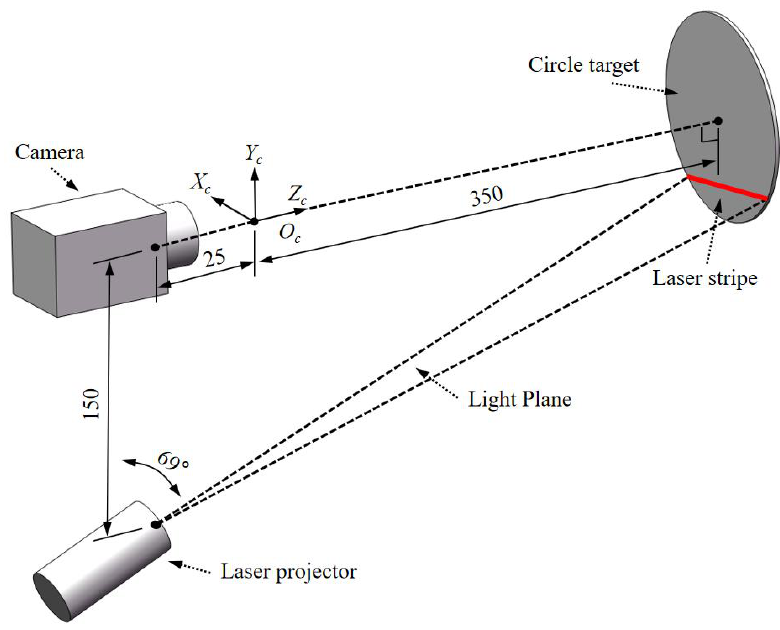
Figure 6. Geometrical layout and dimensions of the simulation case (unit: mm).